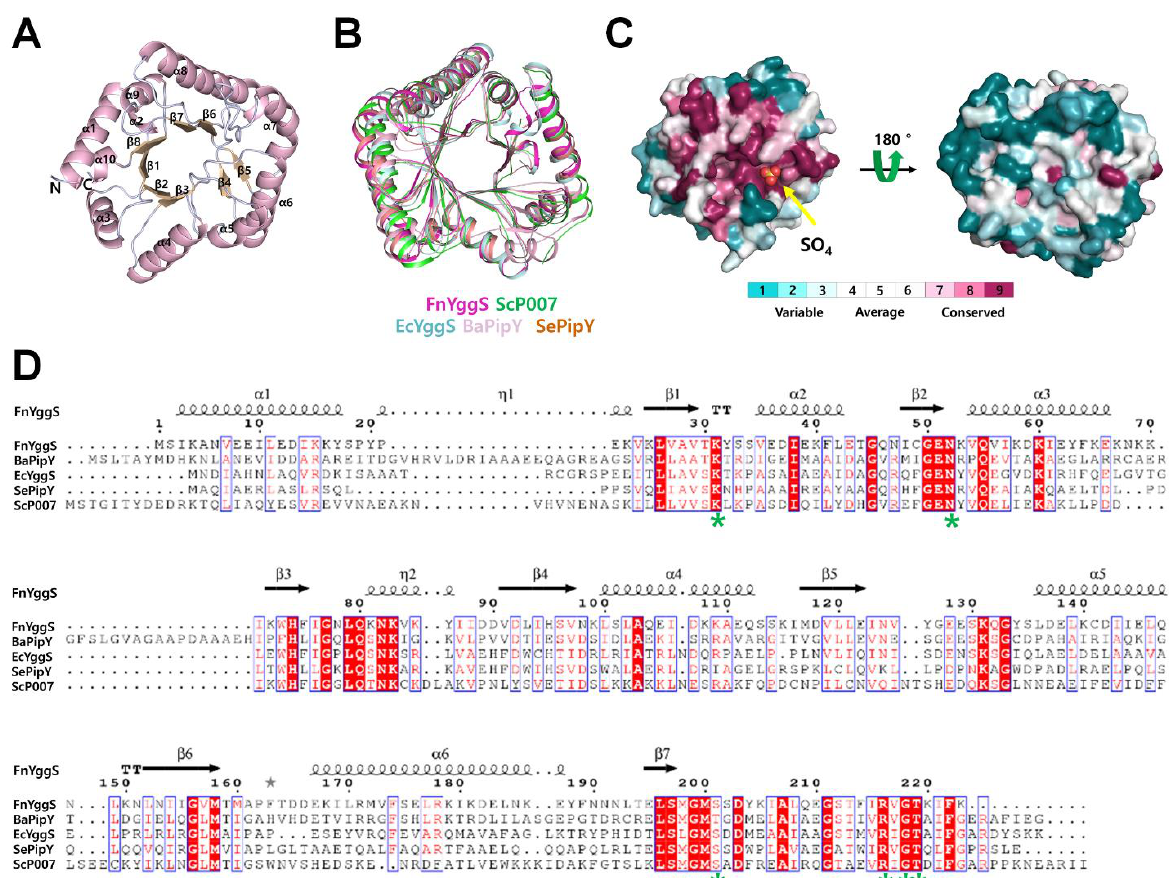
Figure 2. Crystal structure of FnYggS. ( A ) Cartoon representation of the FnYggS monomer consisting of a typical TIM barrel fold. ( B ) Superimposition of FnYggS (purple, PDB ID: 7YGF) onto ScP007 (green, PDB ID: 1B54), EcYggS (blue, 1W8G), BaPipY (pink, 3CPG), and SePipY (brown, 5NM8). ( C ) Surface conservation of PipY proteins. The PLP-binding site showed high conservation, whereas other regions were not conserved. The PLP-binding site is indicated by the yellow arrow. ( D ) Sequence alignment of FnYggS (UniProt accession no. Q8RFW9) with BaPipY (A1A3G9), EcYggS (P67080), SePipY (Q31LH9), and ScP007 (P38197). The residues forming the PLP-binding site are indicated by the green asterisks. Table 1. Data collection and refinement statistics for DendFP.